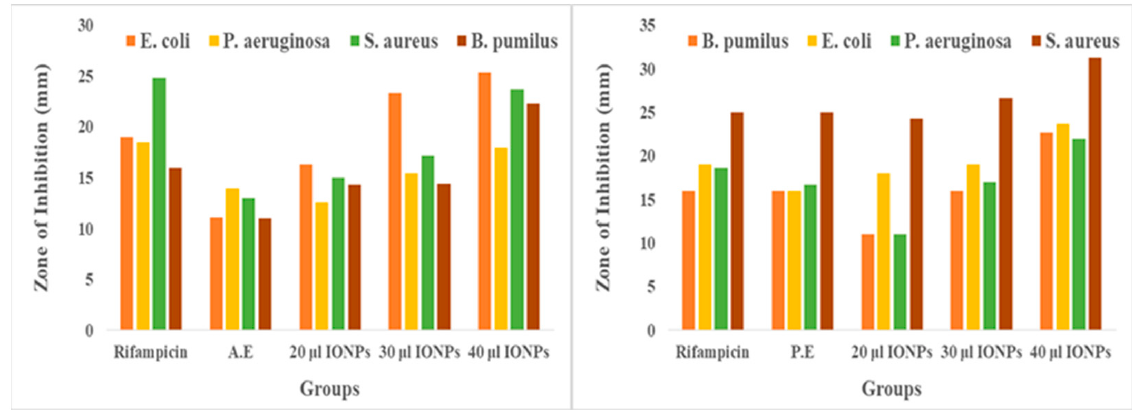
Figure 8. Antibacterial activity of positive controls, AE, PE, and algal- and plant-based Fe 3 O 4 NPs, was evaluated by the well diffusion method against model gram-positive and gram-negative bacterial strains. Because the experiment was repeated three times, the values are reported as the mean ± SEM.